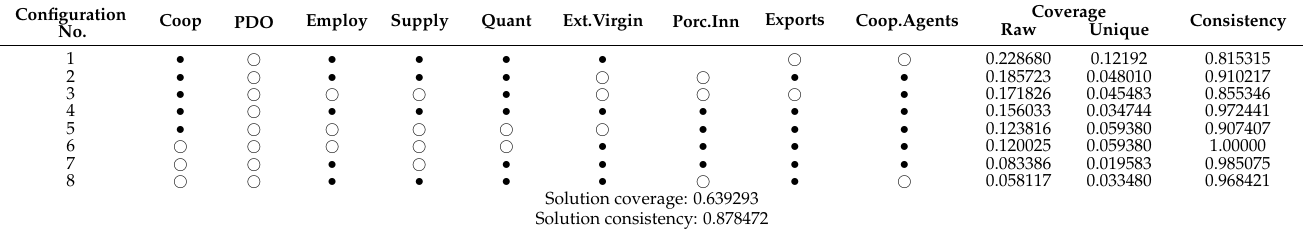
Table 4. Models predicting the involvement of olive oil mills in different types of eco-innovations. Configuration